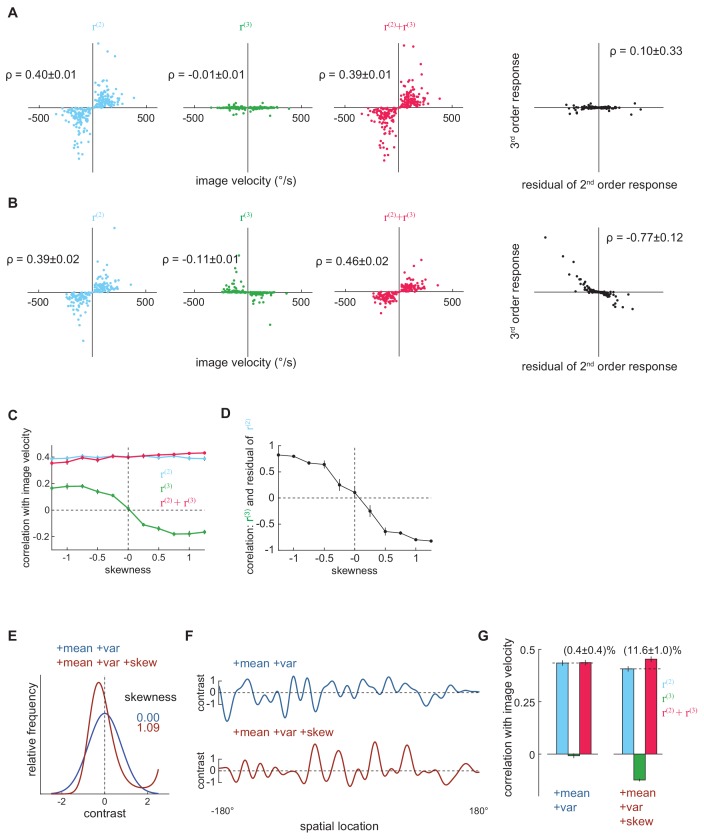
The performance of the measured kernels in various synthetic image datasets.(A) Scatter plots between the model responses and true image velocities when we constrained the synthetic images to match only the mean and variance of the natural images. (B) As in (A), but in this case, we also constrained the synthetic images to match the skewness of the natural image. (C) The performance of the measured kernels as skewness varied in synthetic datasets. (D) The correlation between the third-order responses and the residual in the second-order responses as a function of the skewness in synthetic datasets. (E) In comparison to Figure 5CD, where the contrast range of the MEDs matched the natural images, the contrast range of the MEDs here were fixed to be [−2.5, 2.5]. (F) Example images from these two distributions. (G) The Pearson correlation coefficients between the true image velocities and each kernel’s responses in the two synthetic datasets when the contrast range was fixed.